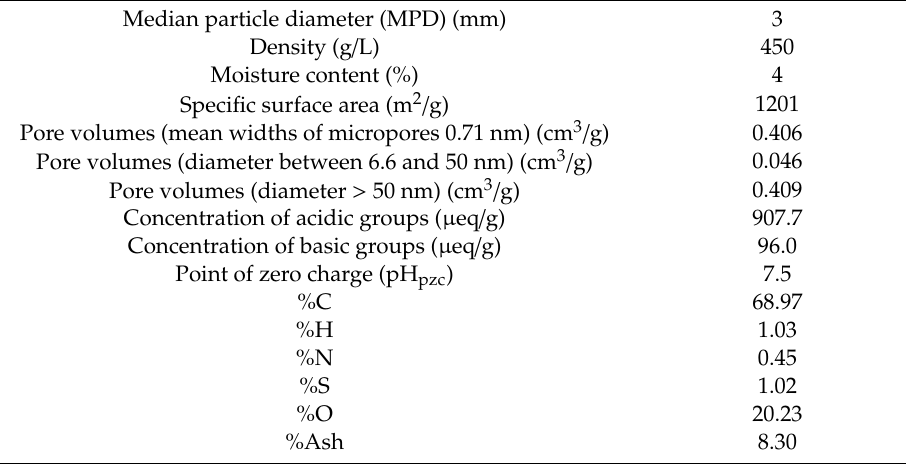
Table 1. Main physic-chemical characteristics of activated carbon